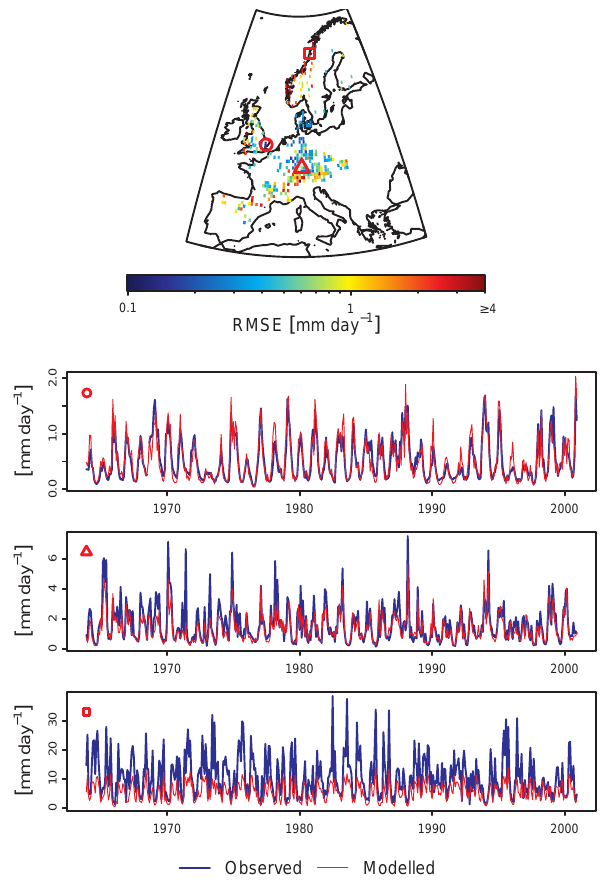
Figure 5. Example time series. The top panel shows the RMSE of the random forest model with full atmospheric forcing (Eq. 2). The symbols mark the grid cells with the lowest (circle), median (tri- angle) and highest (square) RMSE. The corresponding time series of observed and modelled monthly runoff are shown in the lower panels.